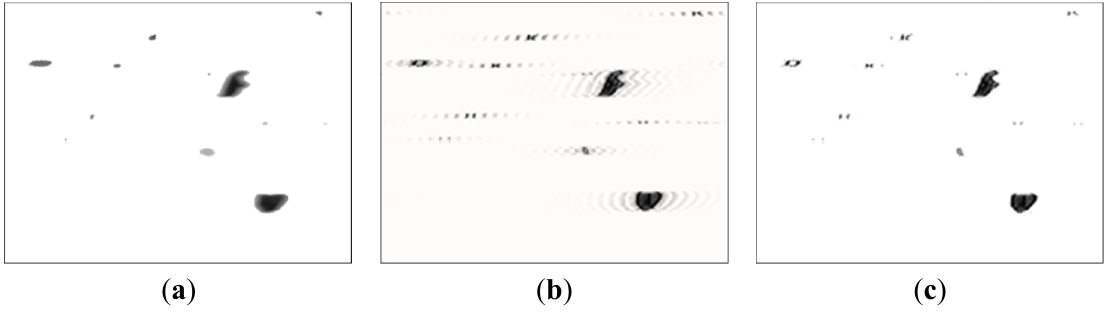
Figure 9. Result images during the restoration process: ( a ) original segmented image; ( b ) restored image; and ( c ) output image after morphological